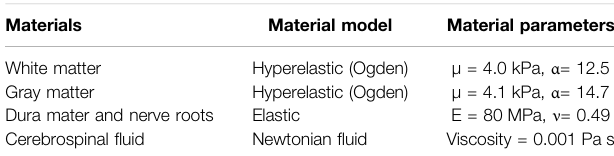
TABLE 2 | Material properties of the spinal